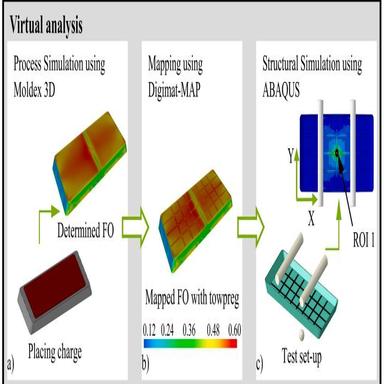
Workflow of virtual analysis of the designed grid-like structures (FO and ROI meaning fibre orientation and region of interest, respectively).